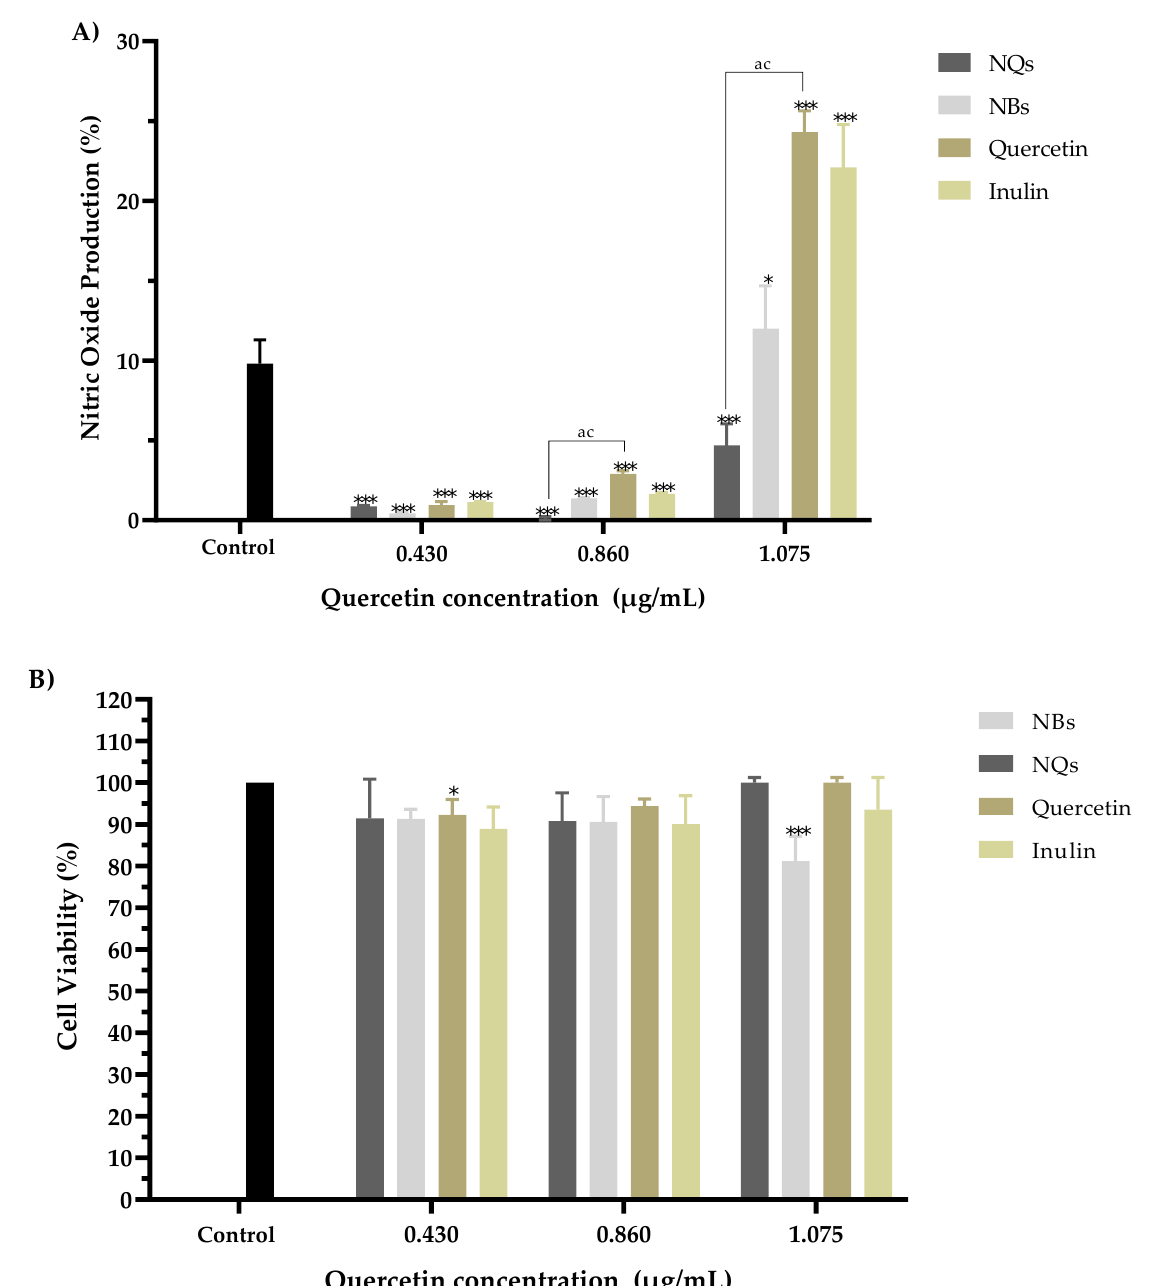
Figure 14. The nitric oxide production assay. Nitric oxide production (%) action of inulin nanoparticles loaded with quercetin (NQs), inulin non-charged nanoparticles (NBs), quercetin and inulin on NO production in Murine macrophage cells (RAW 264.7). ( A ) Effects with 0.430, 0.860 and 1.075 µ g/mL quercetin concentrations (all samples were standardized to the quercetin concentration) for 8 h. ( B ) Cell viability of the extracts at 8 h in RAW 264.7 cells at 0.430, 0.860 and 1.075 µ g/mL quercetin concentrations (all samples were standardized to the quercetin concentration), with 10 µ g/mL of LPS. Each treatment was carried out in triplicate. Evaluations were made using the two-way ANOVA, with Dunnett’s multiple comparisons, where * represents p < 0.05, and *** represents p < 0.001 compared to the control group. Significant differences were determined based on the Student’s t-distribution ( p ≤ 0.05) where ac represents NQs vs. quercetin.